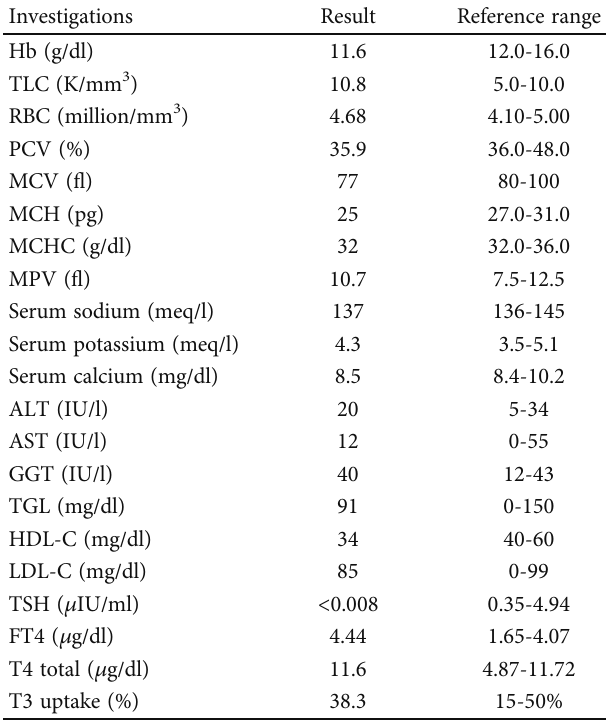
Table 1: Laboratory investigations of the patient.